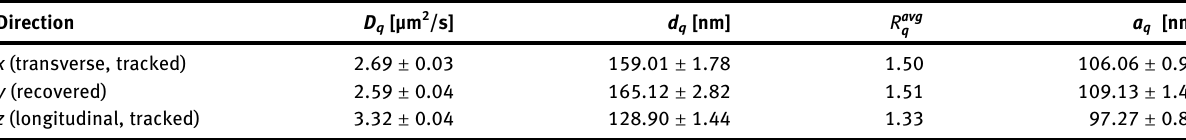
Table  : Results of the MSD analysis ( q = x , y and z ).